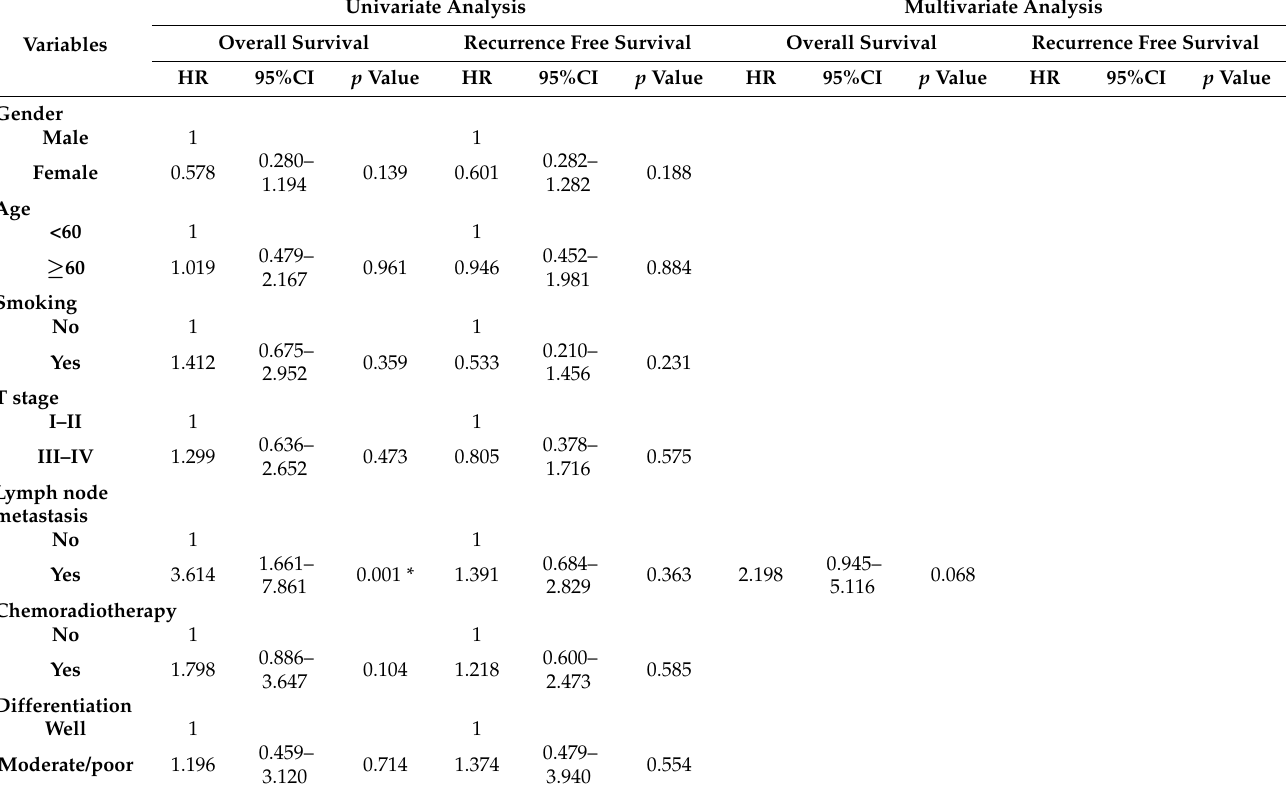
Table 2. Cox-regression analysis of OS and RFS in OSCC patients.